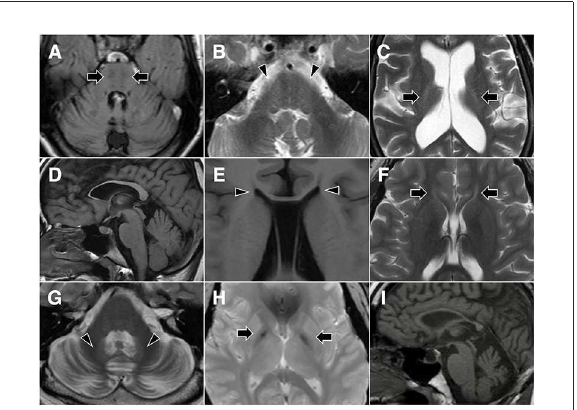
FIGURE2 Representative brain MR images. Patient R2 shows horizontal hypointensity strips on FLAIR imaging ( A , arrows), along with a hyperintense zone in the lateral pons on T2-weighted imaging ( B , arrowheads) and a hyperintense peri-thalamic rim ( C , arrows). Patient S13 shows thin corpus callosum (D) and a box-shaped calloso-caudate angle ( E , arrowheads) on T1-weighted imaging, as well as hyperintense streaks in the forceps minor of the corpus callosum (“ears of the lynx” sign) on T2-weighted imaging ( F , arrows). Patient D4 demonstrates cerebellar atrophy and T2 hyperintensity of the dentate nucleus ( G , arrowheads), as well as T2 gradient-echo hypointensity of the medial globus pallidus ( H , arrows). Midsagittal T1-weighted imaging of patient S2 shows thin corpus callosum and cerebellar atrophy (I) .